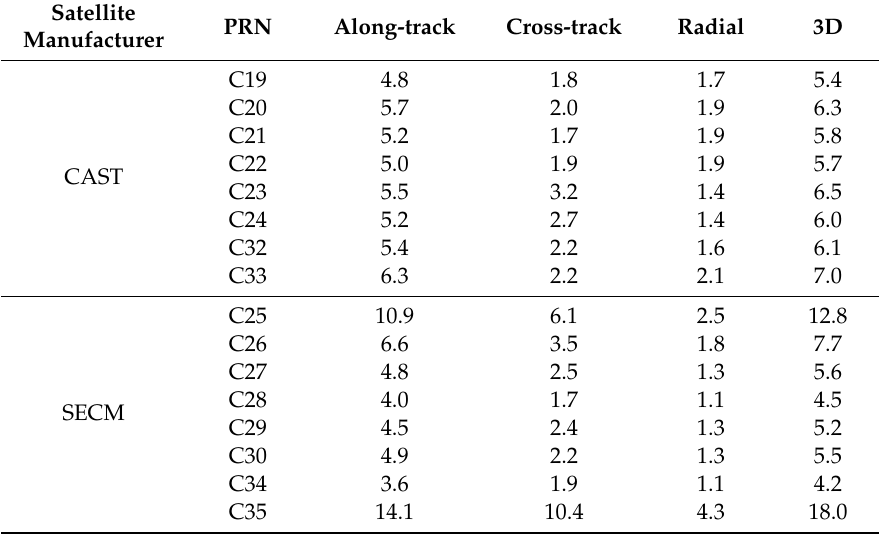
Table 6. The results of the two-day overlap comparison of BD3 medium Earth orbit (MEO) satellites in the along-track, cross-track, radial and 3D directions (units: cm).